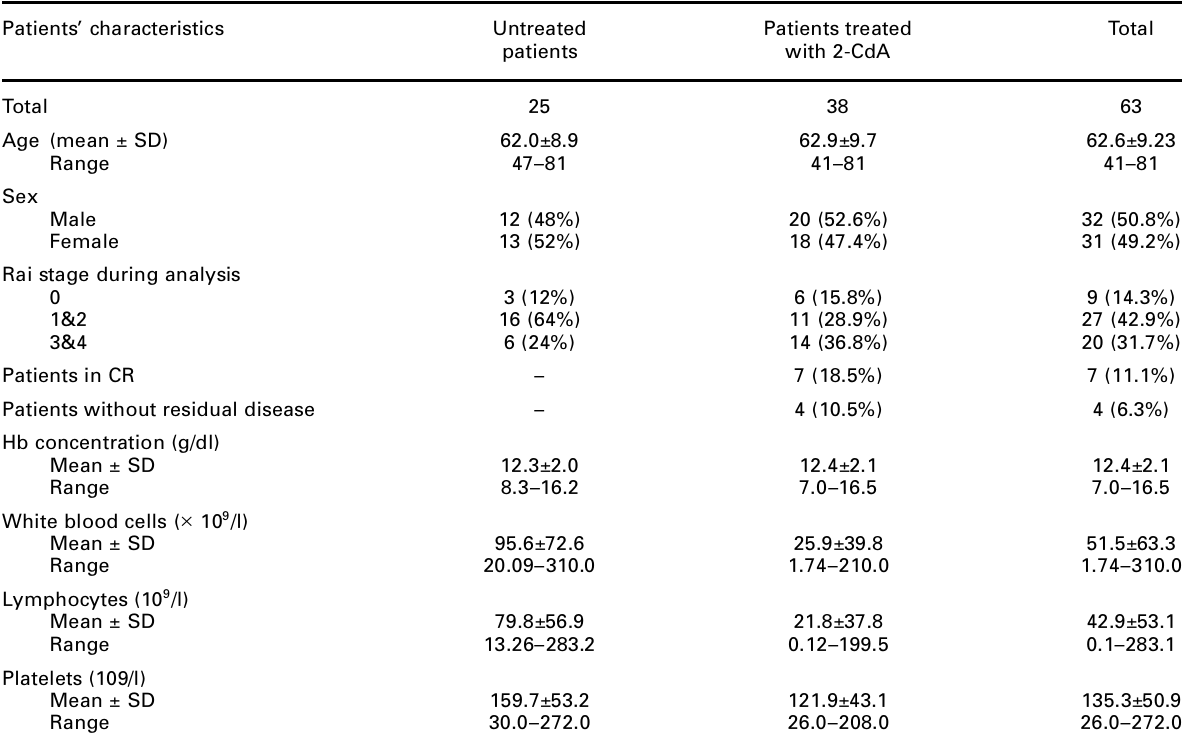
Table 1. Clinical and laboratory characteristics of the patients with CLL Patients’